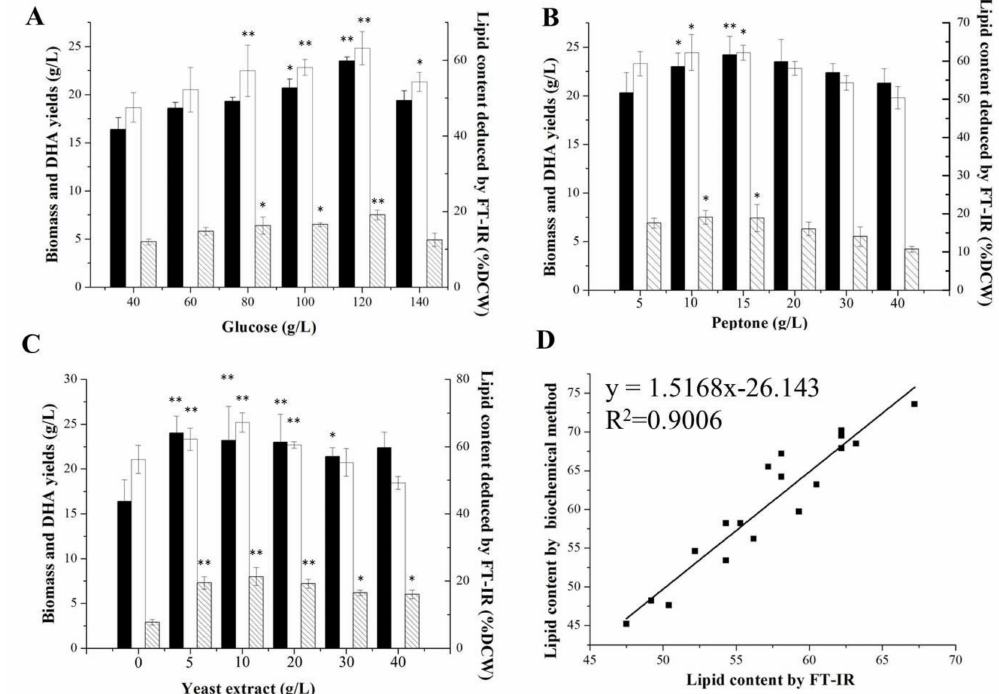
Figure 4. Di ff erent concentrations of glucose, peptone and yeast extract on biomass, lipid and DHA productions in Aurantiochytrium sp. strain No. 6 and evaluation of the related FT-IR results. ( A ), E ff ects of concentrations of glucose on biomass, lipid and DHA synthesis; ( B ), E ff ects of concentrations of peptone on biomass, lipid and DHA synthesis; ( C ), E ff ects of concentrations of yeast extract on biomass, lipid and DHA synthesis; ( D ), the linear relationship between the lipid contents deduced by the traditional method and the FT-IR method. Data are given as means ± standard deviation, n = 3. Filled blank, biomass; White blank, lipid content; blank with diagonal, DHA yield. * p < 0.05; ** p < 0.01 The yield under the medium composed of 40 g / L glucose, 10 g / L peptone, and 5 g / L yeast extract was set as the